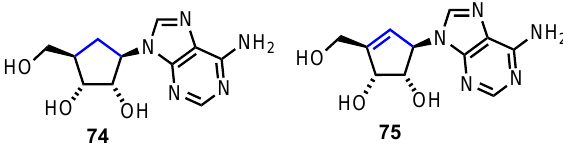
Figure 7. Structures of aristeromycin, 74 , and neplanocin A, 75 .